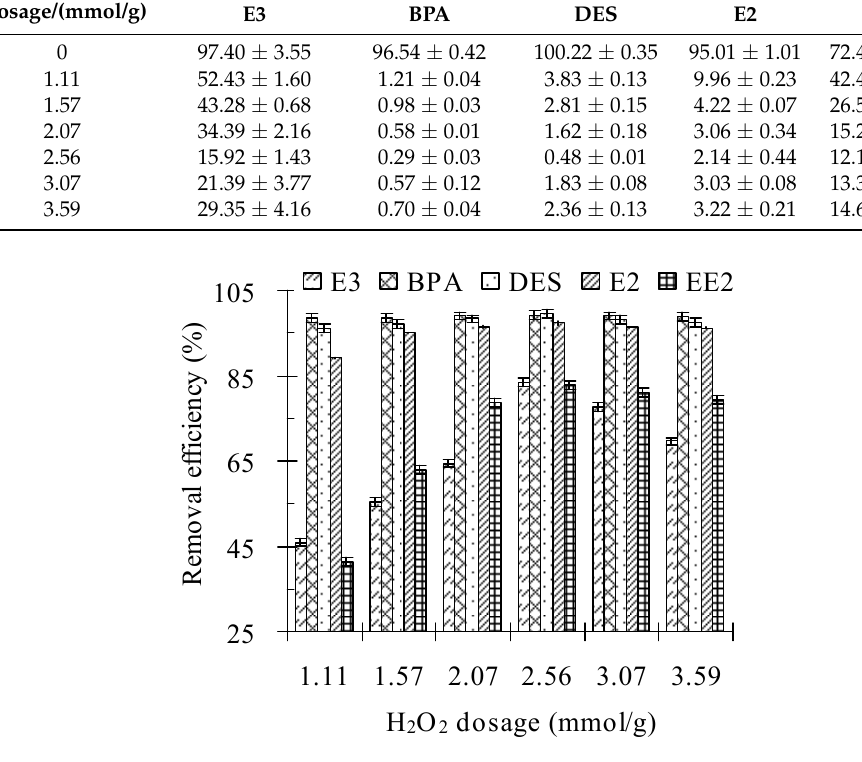
Figure 1. Effect of H 2 O 2 dosage on the removal efficiency of estrogens from cow manure by the Fenton oxidation process. Note: the Fe(II) to H 2 O 2 molar ratio was 0.10 M/M; the solid to water mass ratio was 2 g/mL; the initial pH value was 3.0; the reaction time was 24 h. Error bars represent standard deviations.